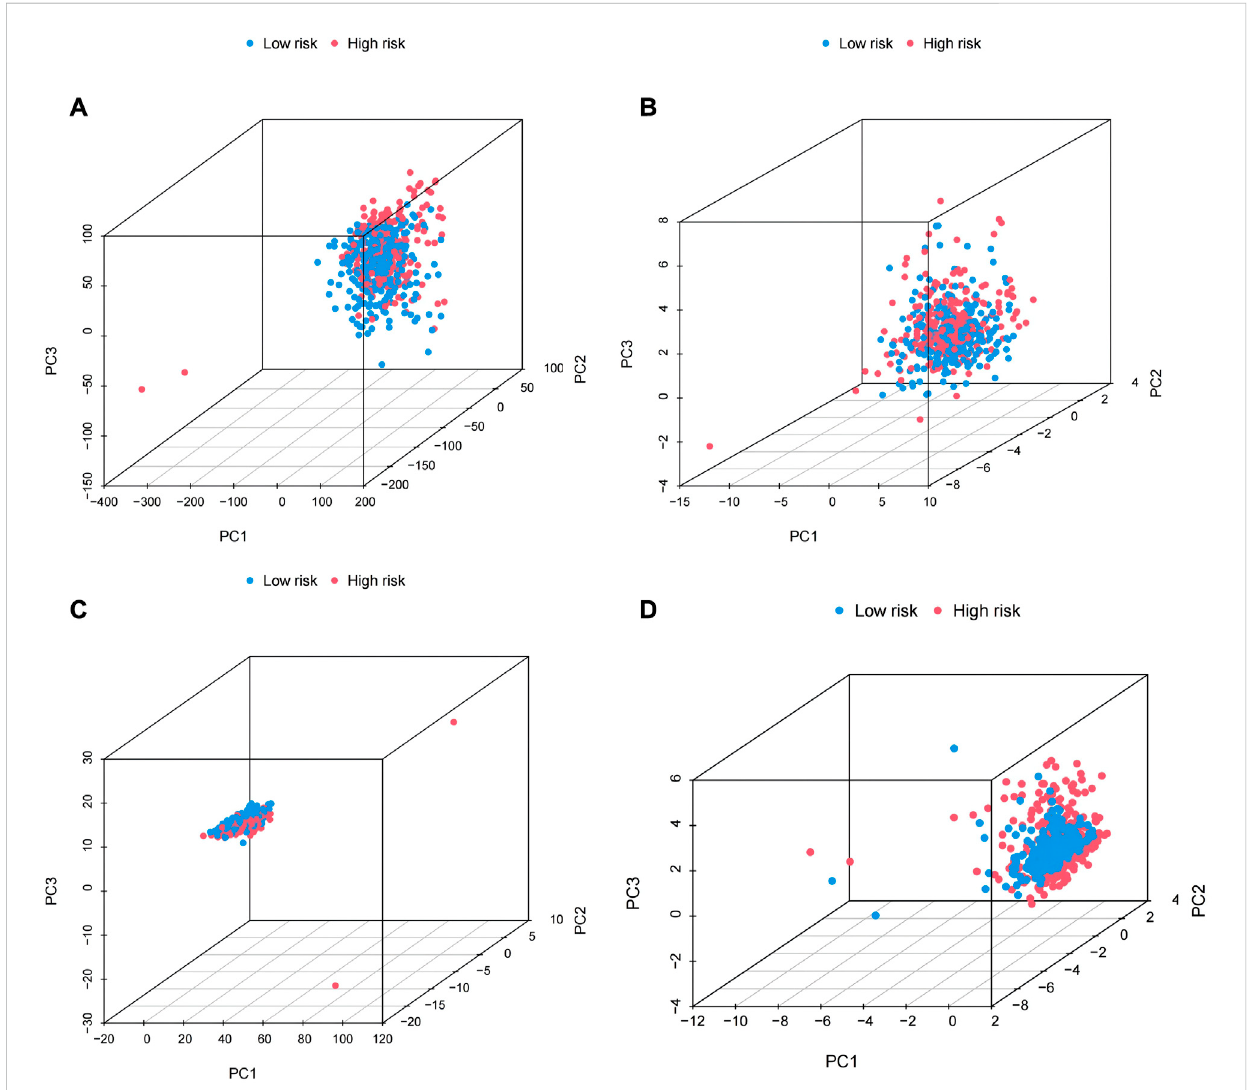
FIGURE 9 PCA analysis. (A) Plot for all genes. (B) Cuproptosis-related genes. (C) Cuproptosis-related LncRNA. (D) The LncRNA at